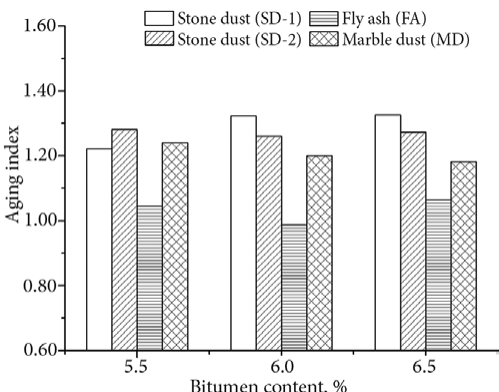
Fig. 9. Aging index of OGFC mixes